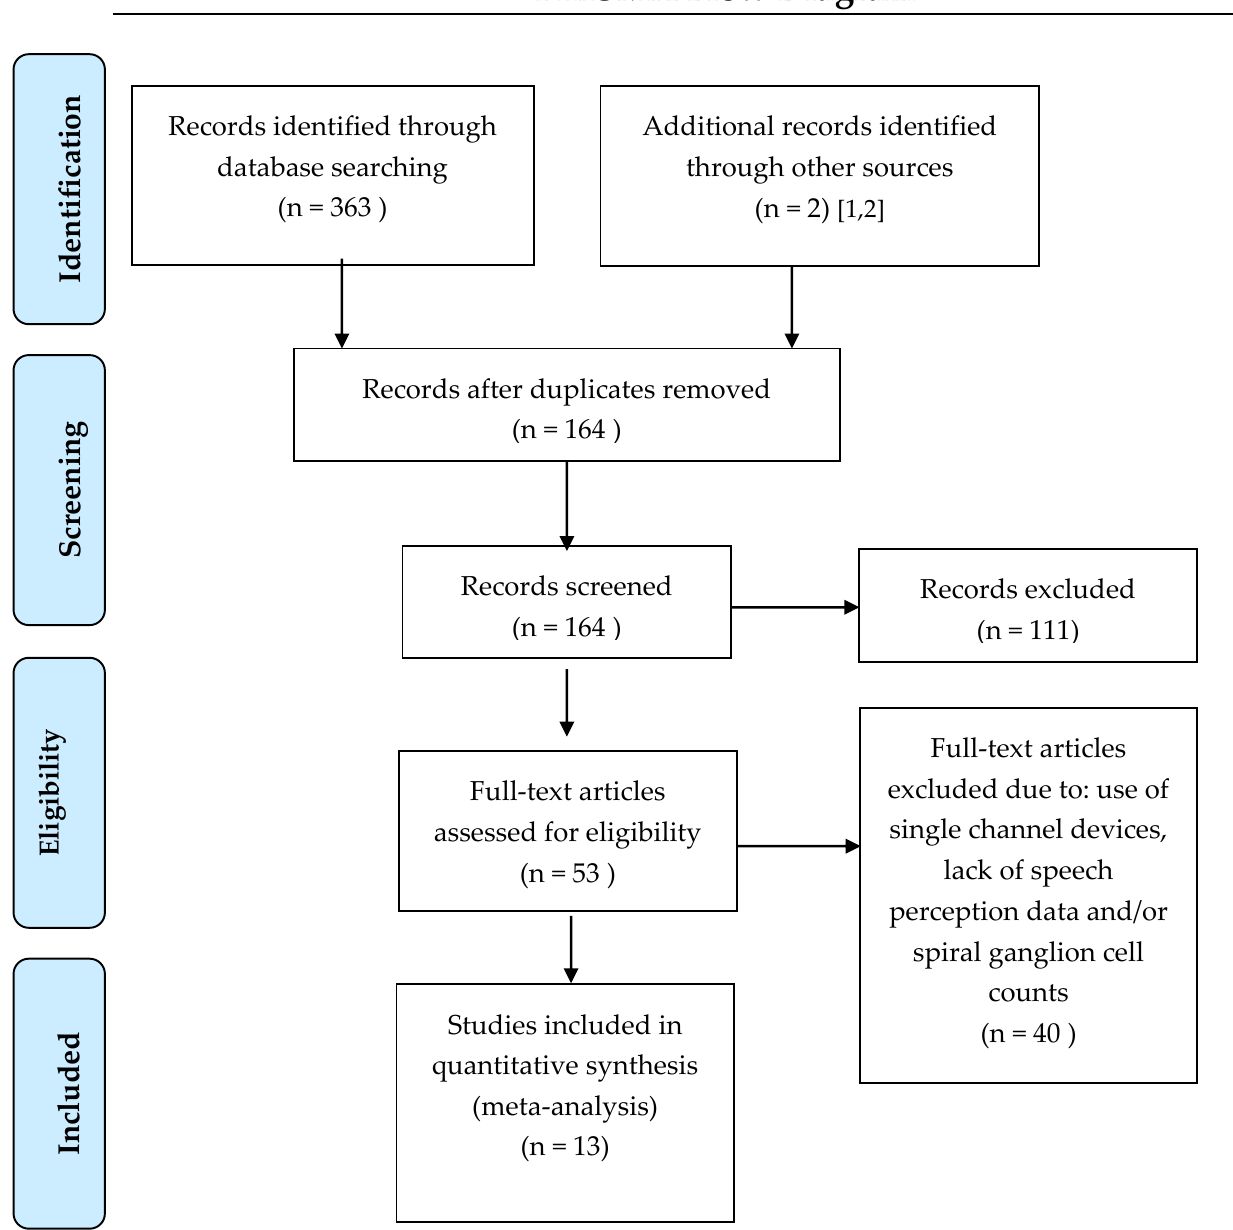
Figure 1. PRISMA 2009 flow diagram. A total of 13 studies were included in this quantitative synthesis [11,12,15–17,19–26].